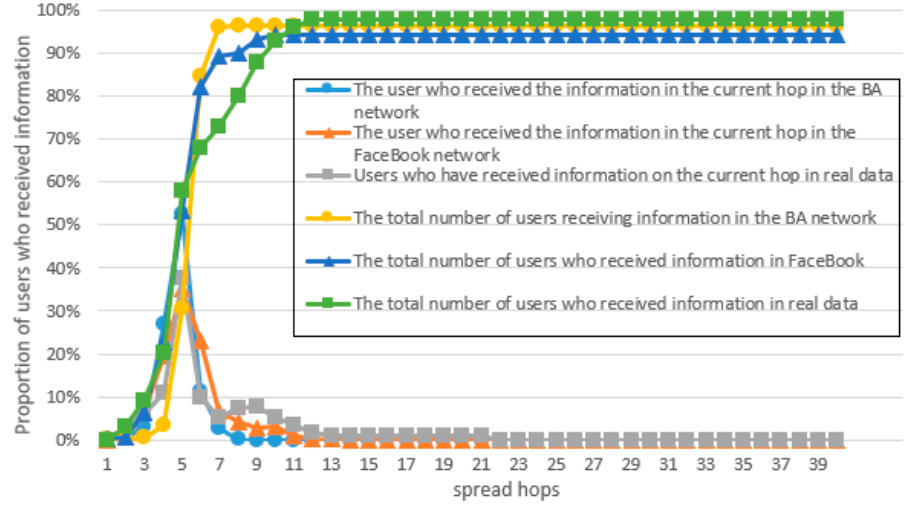
Figure 13. Dissemination of the privacy information of a highly popular user between simulated data and real data.